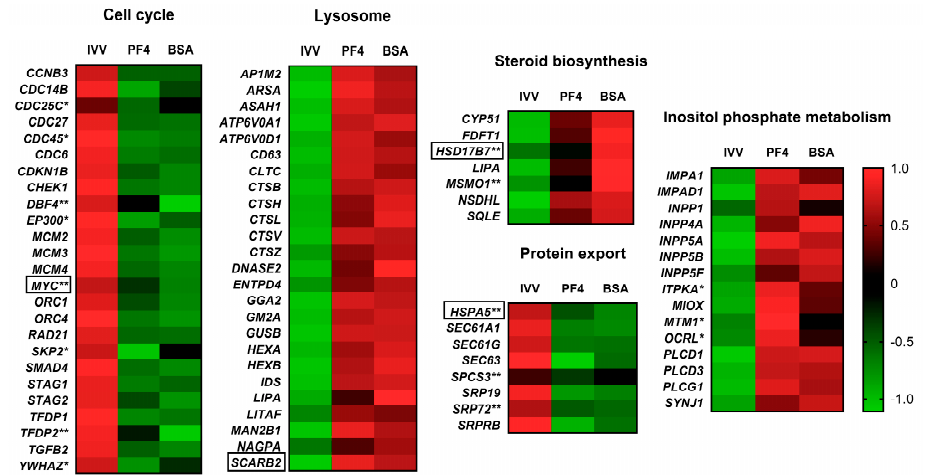
Figure 5. Representation of the different pathways considered altered (p value < 0.05) obtained from the (A) upregulated differentially expressed genes (upregulated pathways) and from (B) the downregulated differentially expressed genes (downregulated pathways). The enrichment values for each pathway are indicated by a circle in the case of the comparison between in vitro embryos cultured in defined medium (PF4: platelet factor 4) and in vivo-derived embryos (IVV) and by a square in the case of the comparison between in vitro embryos cultured in undefined medium (BSA: bovine serum albumin) and IVV embryos. The size of the symbol indicates the percentage of affected genes out of the total number of genes belonging to that pathway. The color of the symbol indicates the p-value of each pathway.